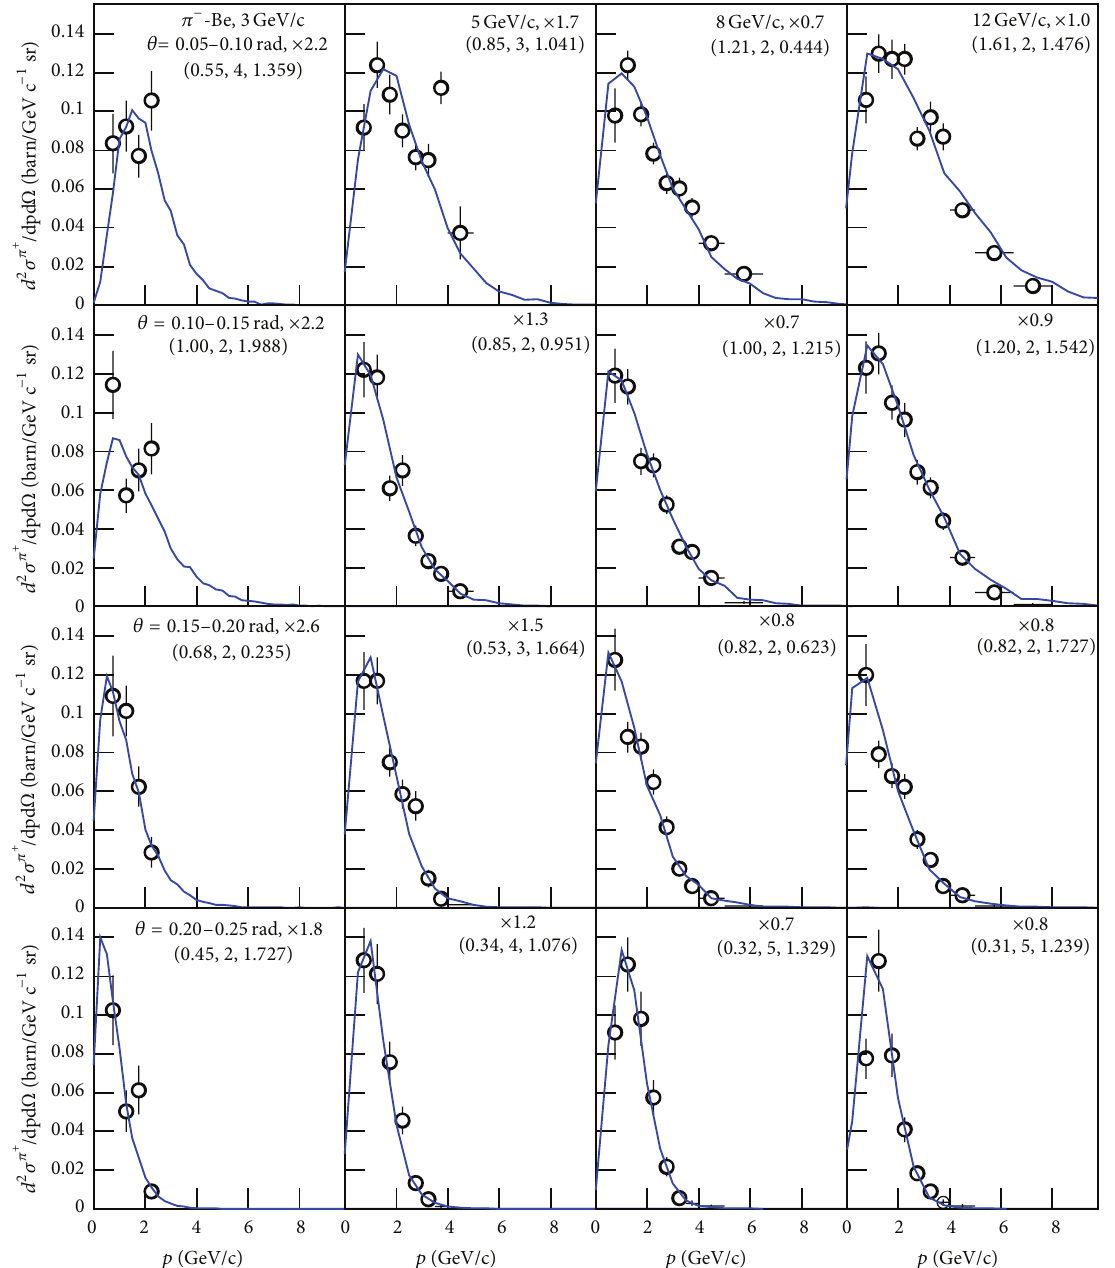
Figure 1: Double-differential 𝜋 + production cross sections in 𝜋 − -Be interactions at high momentums. The circles represent the experimental data of the HARP Collaboration [35] and the curves are our calculated results. Different panels are scaled by multiplying different amounts marked in the panels. The three numbers in ( ⋅⋅⋅ ) in each panel represent the values of ⟨𝑝 𝑖1 ⟩ , 𝑚 1 , and 𝜒 2 /dof,